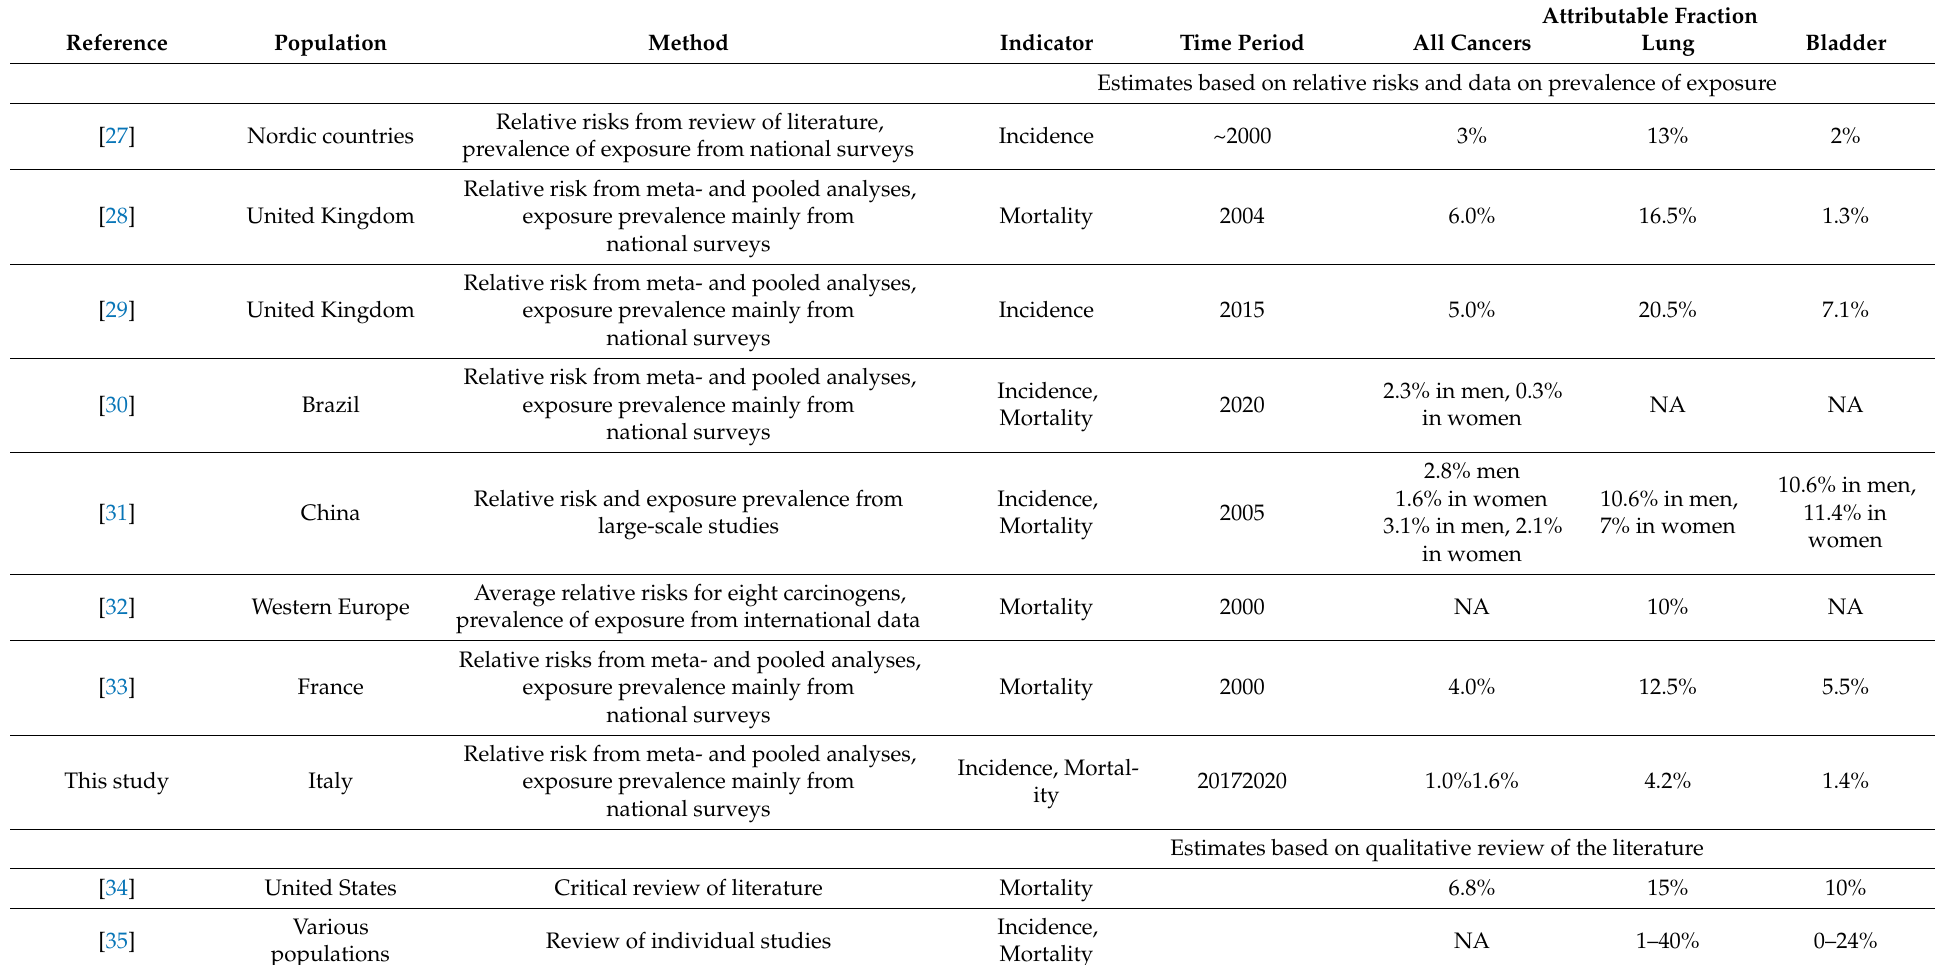
Table 5. Attributable fraction of overall, lung and bladder cancers related to occupational carcinogens according to selected literature.